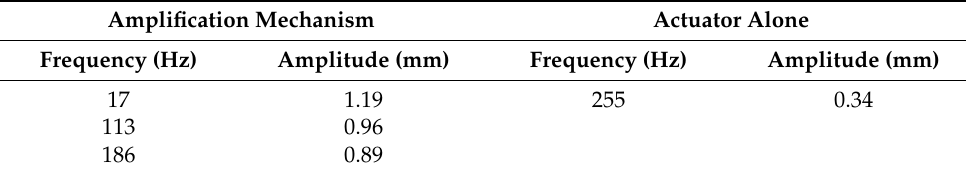
Figure 10. Frequency spectrum of output displacement under 194 Hz square wave input. Single-sided amplitudes at notable resonances are summarized in Table 2. Output amplitudes are up to 110 times the amplitude of the bender alone at low frequencies. Comparing across frequencies, maximum mechanism output is approximately 3.5 times larger than the the largest amplitude for the bender alone. Table 2. Peak amplitudes of dominant oscillation and corresponding input frequencies.